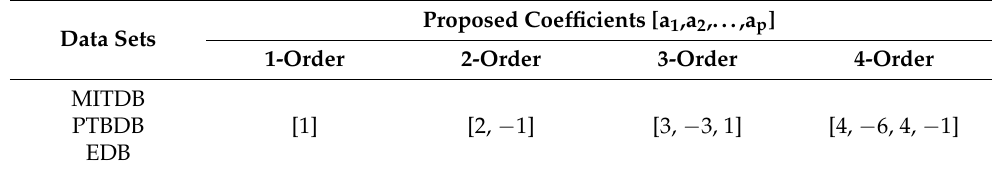
Table 4. Proposed Linear Prediction Coefficients.